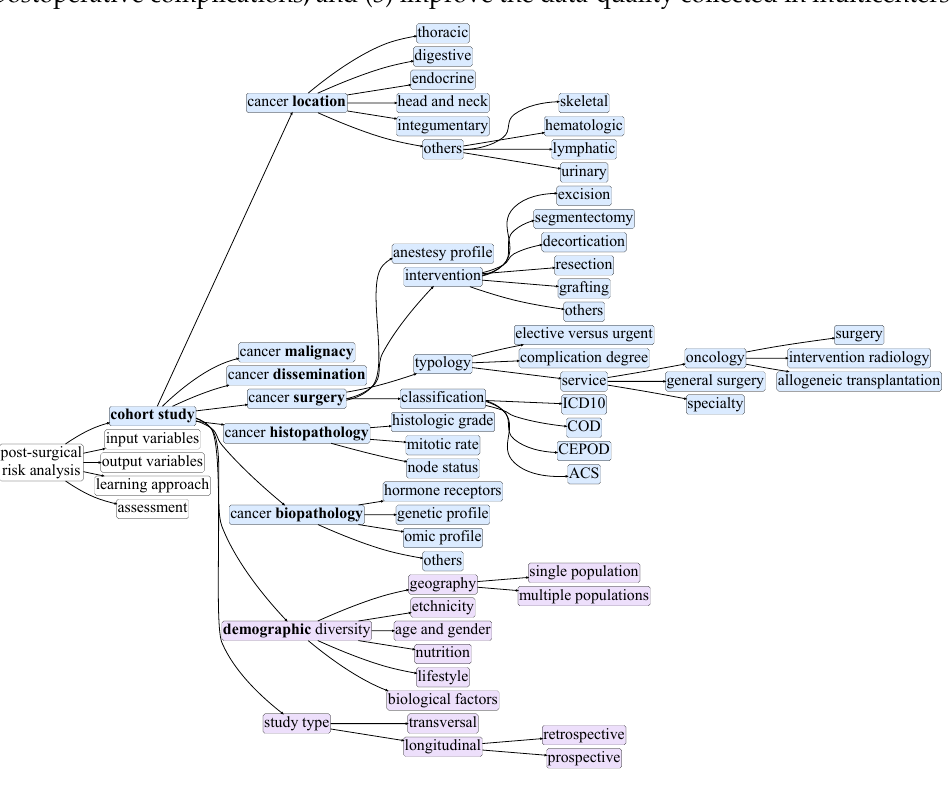
Figure 2. Taxonomy for postsurgical risk analysis: cohort